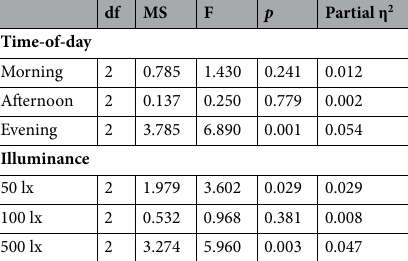
Table 2. The simple effect of illuminance and time-of-day on comfort. MS: mean square; F, p , and partial η 2 refer to the F value, significance level, and effect size from the MANOVA analysis, respectively.